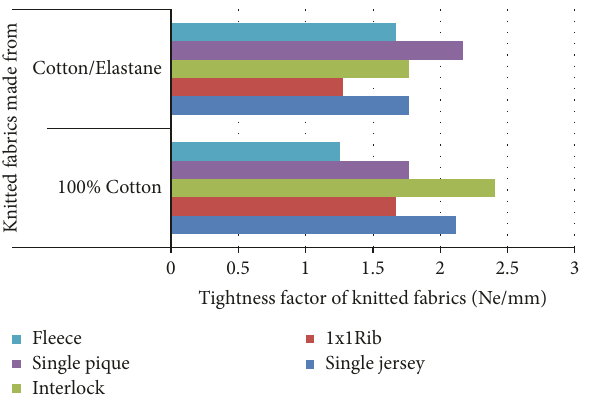
Figure 5: Tightness factor of knitted fabrics made from 100% cotton and cotton/elastane yarns.